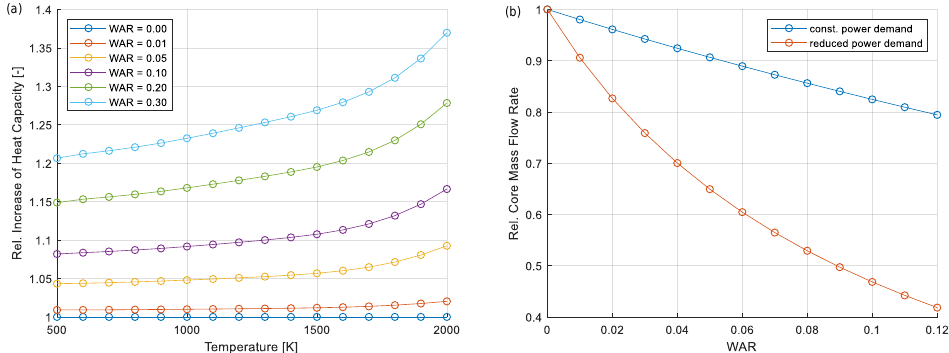
Figure 6. Impact of steam injection in GT combustion chamber on ( a ) the specific heat capacity of turbine working fluid and ( b ) the compressor mass flow rate.